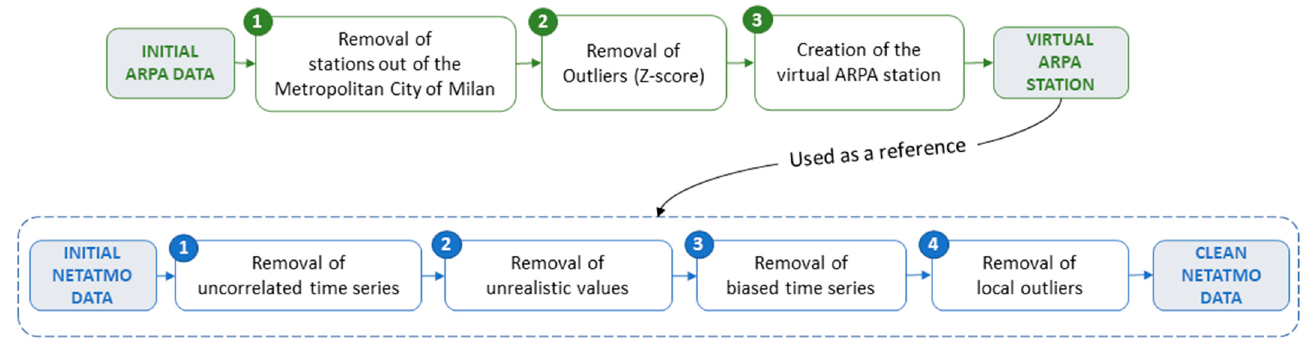
Figure 5. ARPA and Netatmo data pre-processing steps.